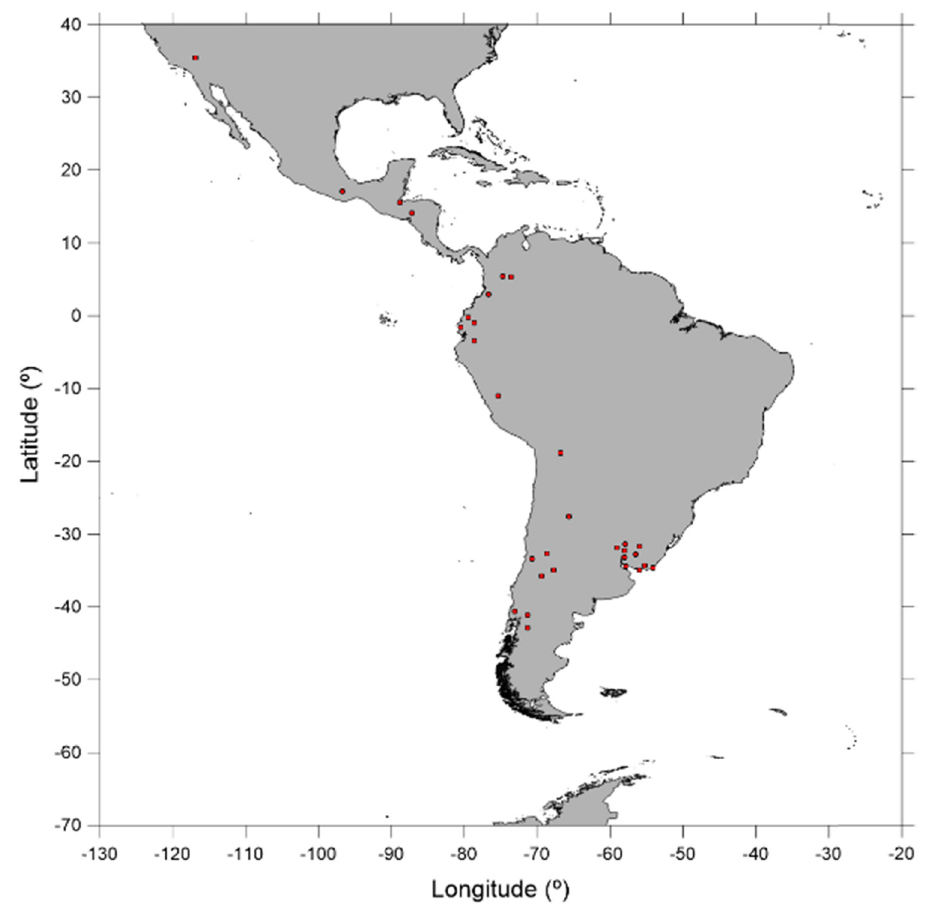
Figure 13: Distribution of SIRGAS - CON stations with some period of high dispersion in the ZTD di ff erences.